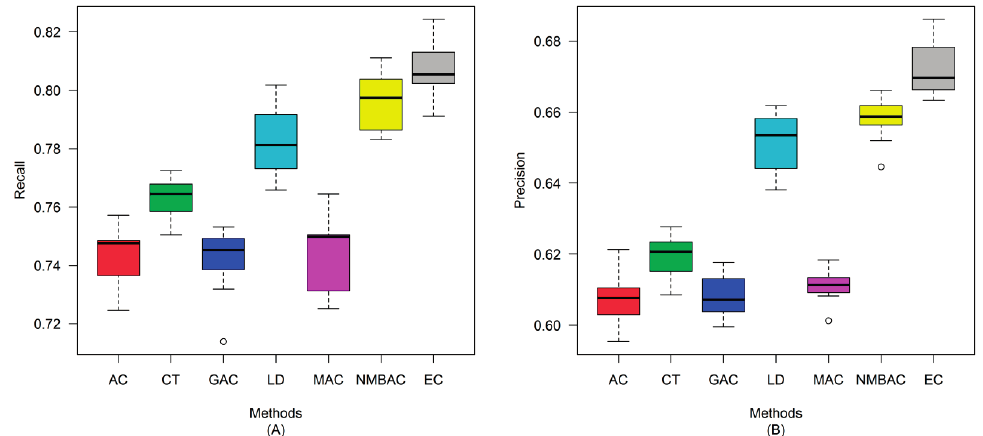
Figure 8. Average recall and precision of different methods on the Gold Yeast dataset with five-fold cross-validation. ( A ) Recall; ( B ) Precision.